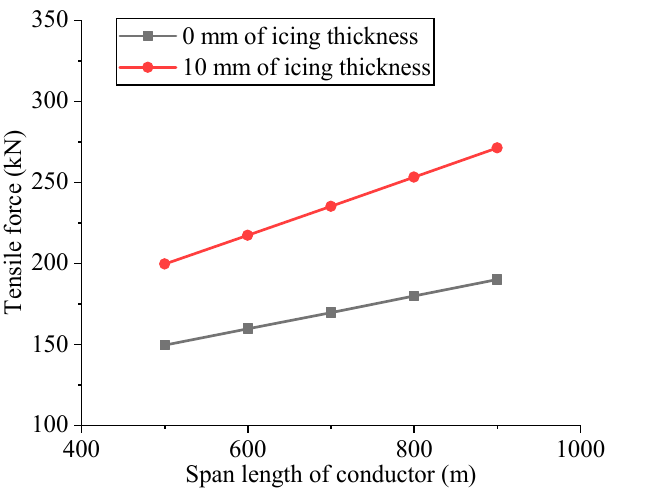
Figure 15. The influence of length of spans of conductor on tensile force of suspension cable (wind speed: 10 m/s).